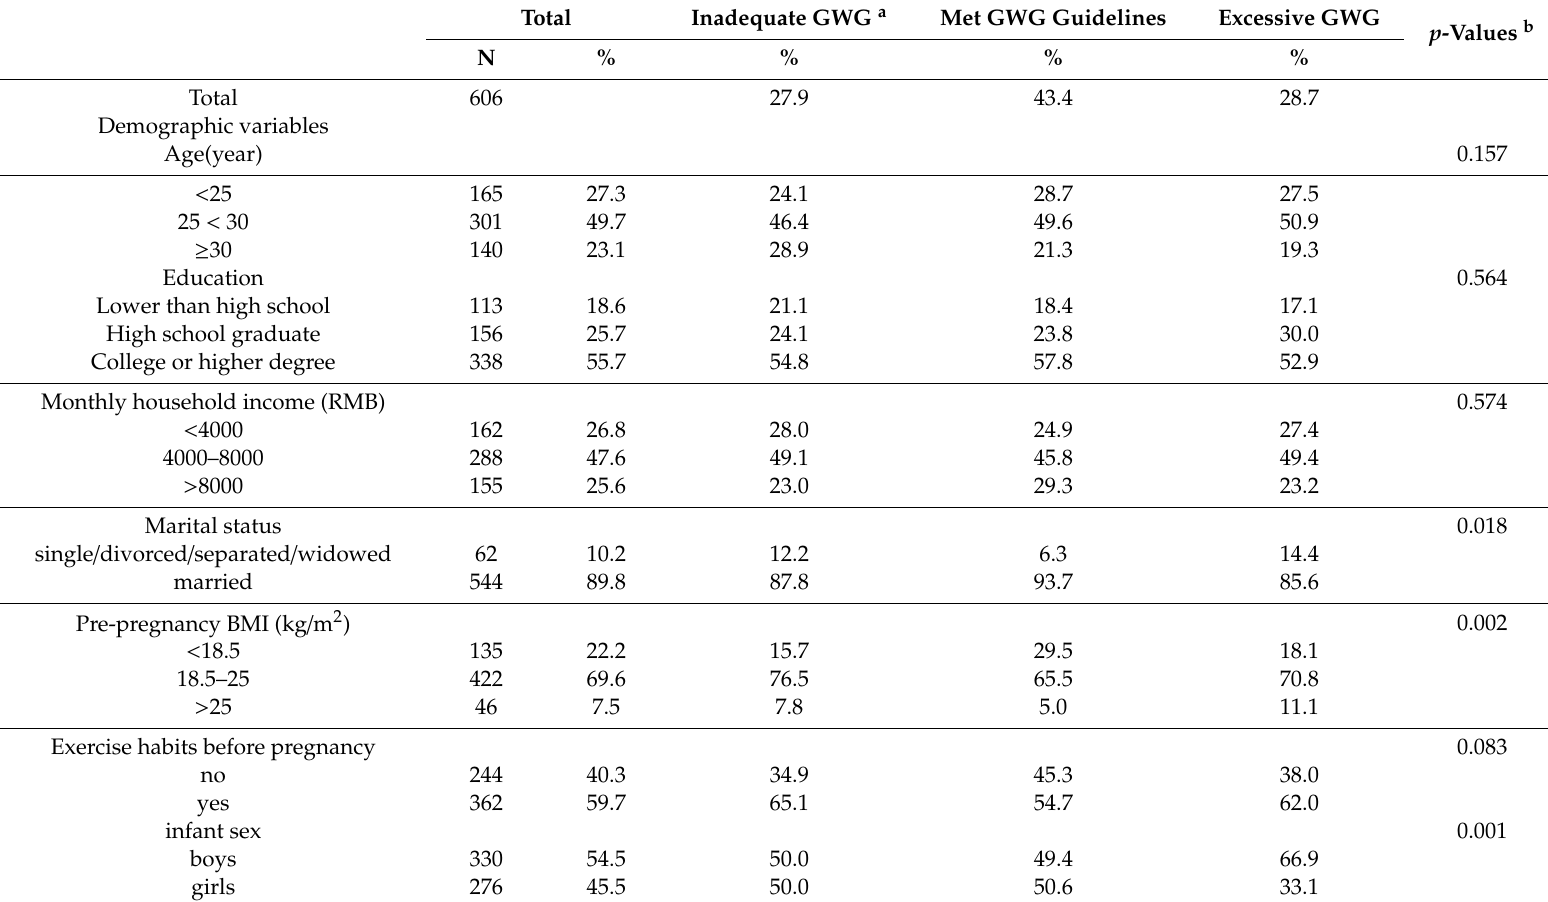
Table 1. Participants characteristics according to compliance with Institute of Medicine (IOM) Guidelines a